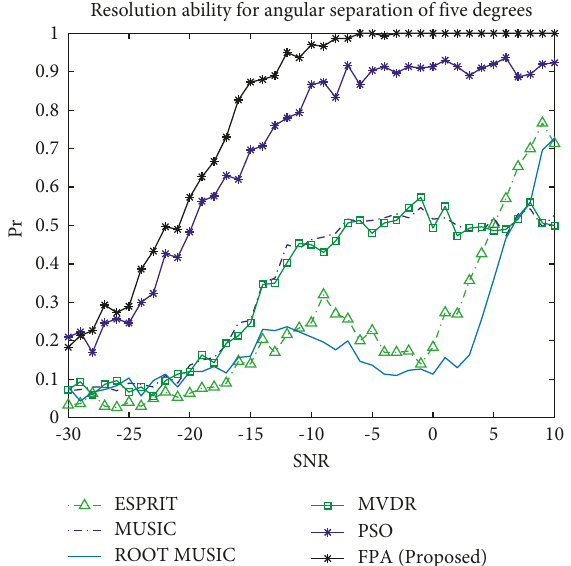
Figure 22: Probability of resolution for the source at 35 degrees.